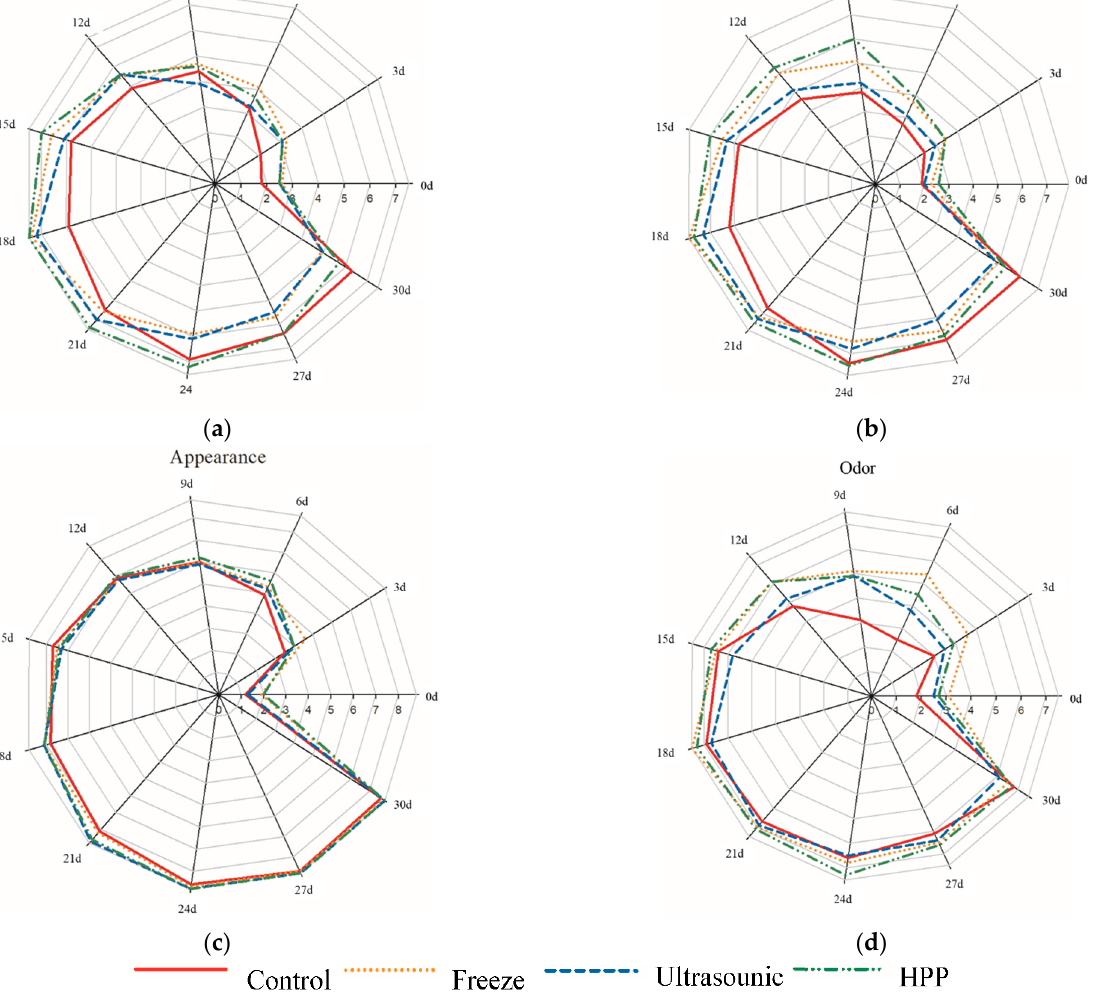
Figure 5. Effects of different processes on the sensory evaluation of black garlic: ( a ) acceptability; ( b ) taste; ( c ) appearance; ( d ) odor. n = 50.